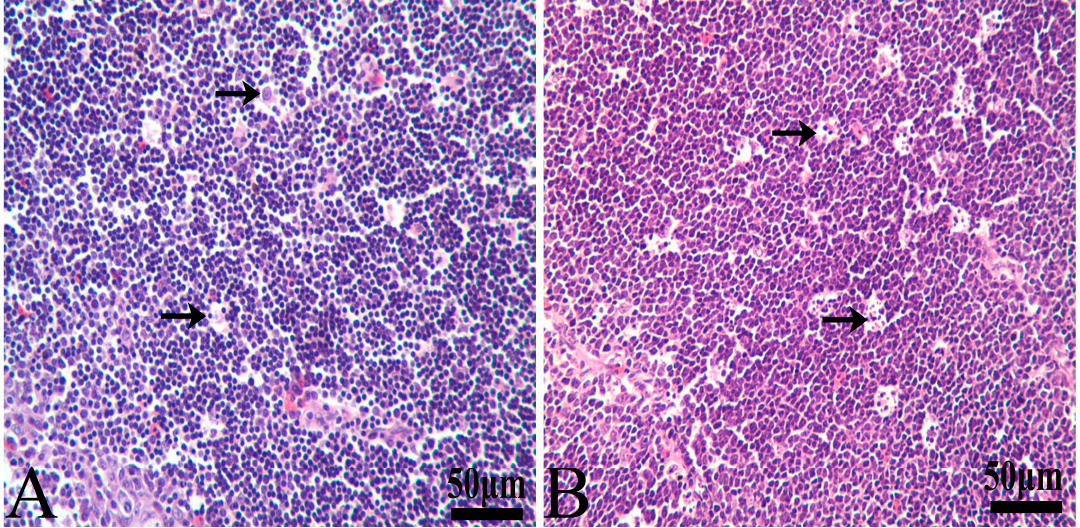
Figure 2. Photomicrographs of hematoxylin- and eosin-stained chicken thymus section at 21 days of age. ( A ) Control group. A little nuclear debris ( → ) can be seen around individual reticular epithelial cells; ( B ) 100% group. Compared with ( A ), there is more nuclear debris ( → ) around reticulocytes. Bars = 50 µm.